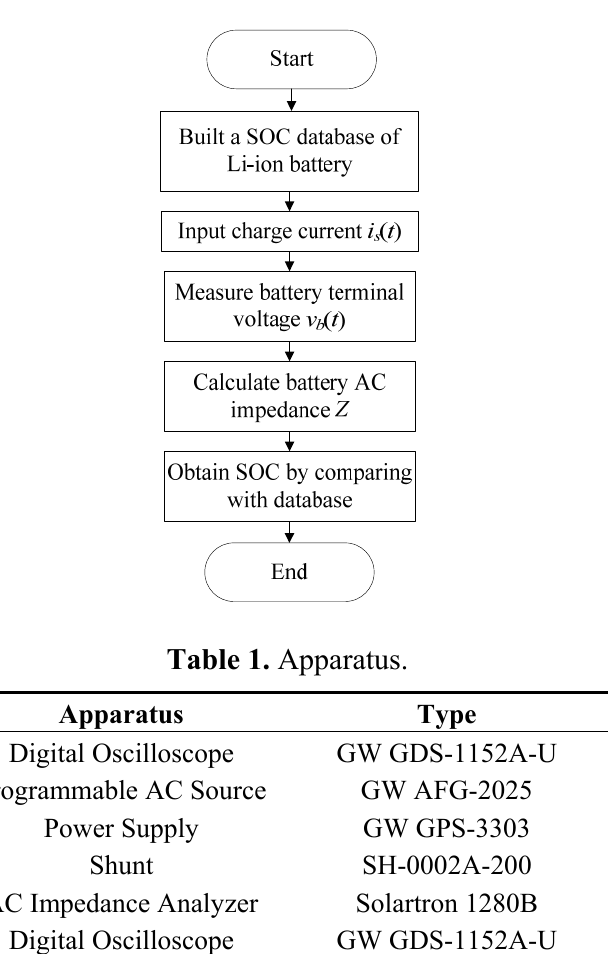
Figure 11. Flowchart of the experiment.